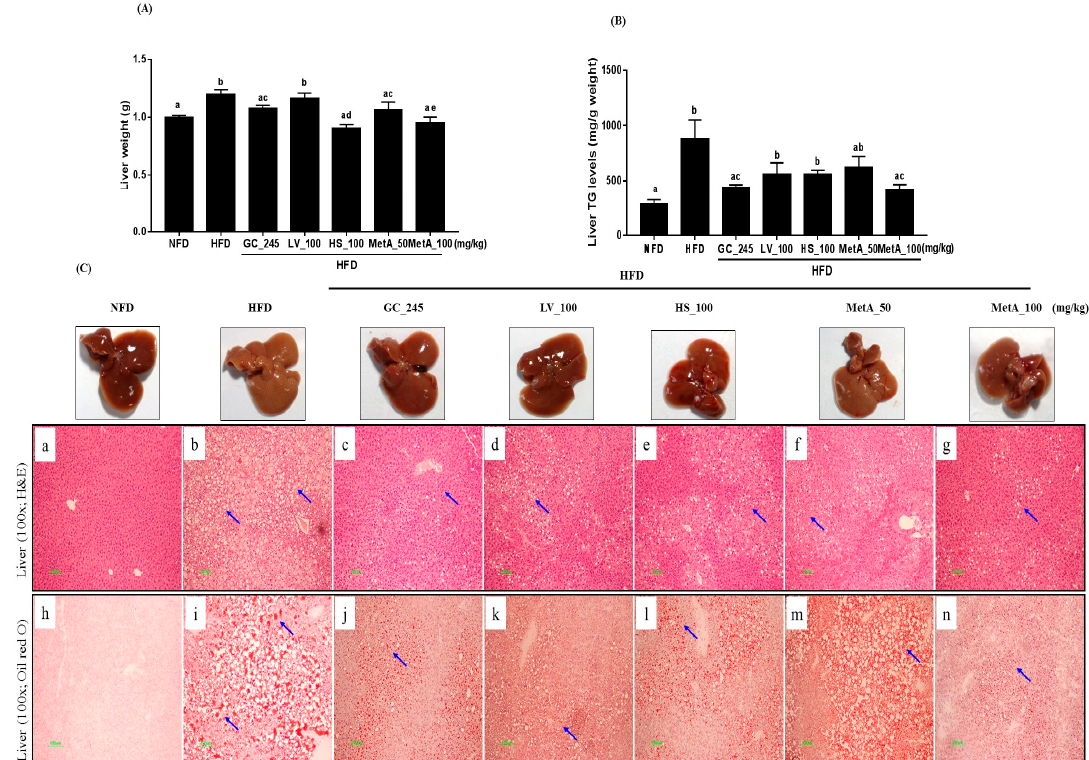
Figure 7. Effects of LV, HS, and MetA on liver weight and hepatic lipid accumulation in HFD-induced obese mice. ( A ) Liver, ( B ) liver TG levels, and ( C ) liver H and E and oil-red O staining. HFD, 60% high-fat-diet control group; HFD + GC_245, HFD contains Garcinia cambogia extract (245 mg/kg)-fed group; HFD + LV_100, HFD contains lemon verbena extract (100 mg/kg)-fed group; HFD + HS_100, HFD contains Hibiscus flower extract (100 mg/kg)-fed group; HFD + MetA_50, HFD contains the MetA-mixed extract of lemon verbena plus Hibiscus flower (50 mg/kg)-fed group; HFD + MetA_100, HFD contains the MetA-mixed extract of lemon verbena plus Hibiscus flower (100 mg/kg)-fed group. Values are expressed as means ± SEM ( n = 10). a–d Values within arrow with different letters are significantly different from each other at p < 0.05 as determined using Turkey’s multiple-range